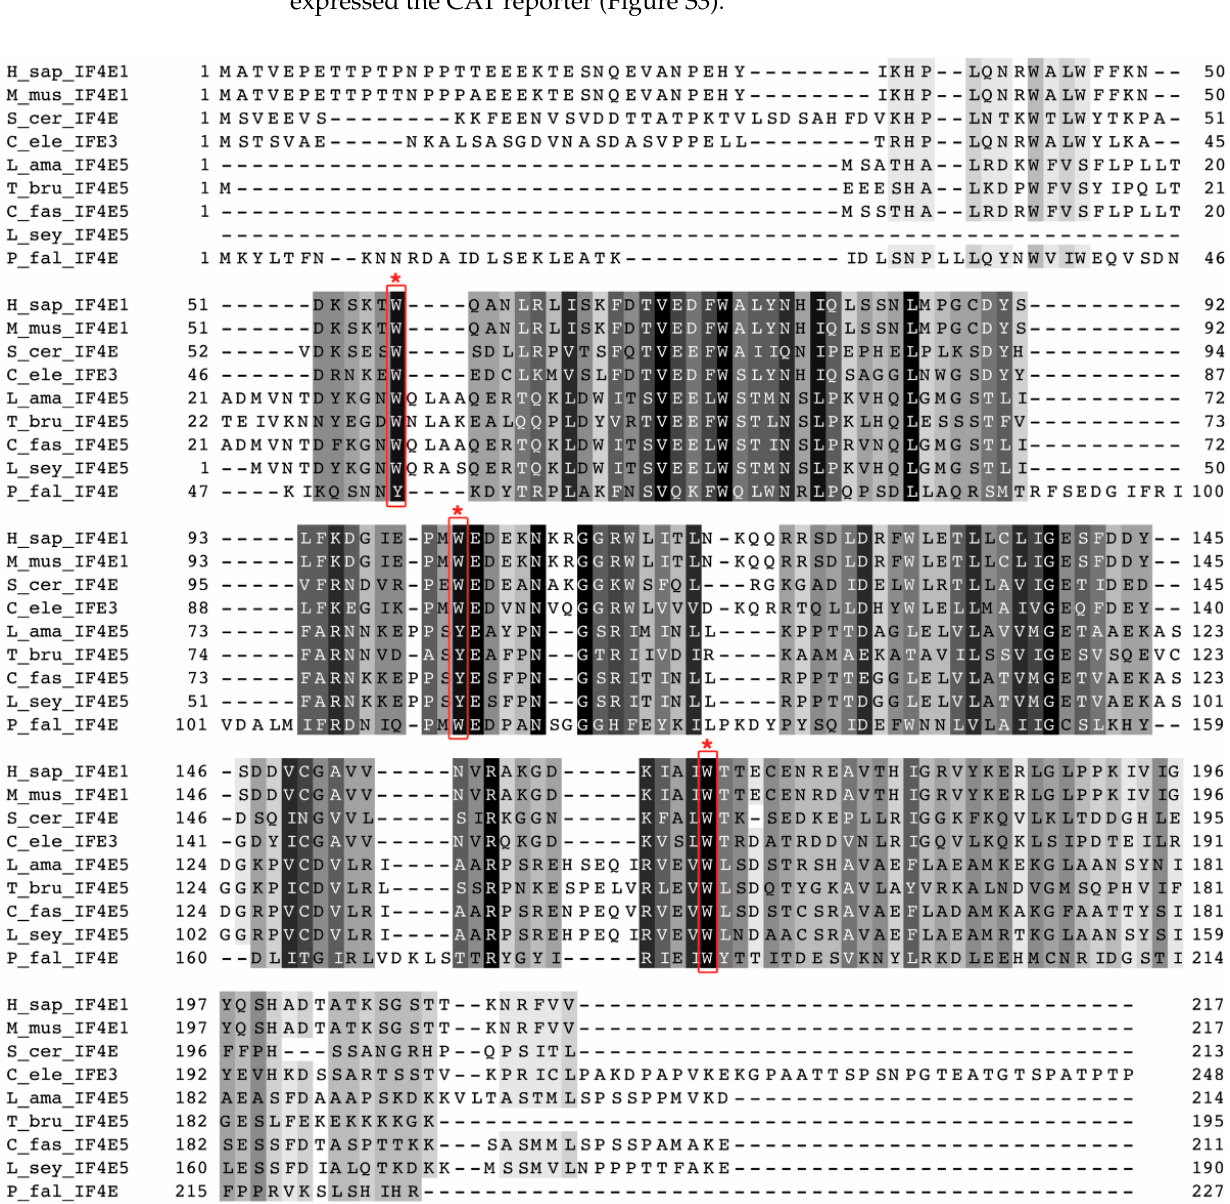
Figure 1. Alignment of LeishIF4E-5 from L. amazonensis with its protozoan orthologs, with eIF4E-1 from mammals, with yeast eIF4E and C. elegans IFE-3 . The alignment includes sequences of LeishIF4E-5 from Leishmania amazonensis (L_ama_IF4E5) , Trypanosoma brucei (T_bru_IF4E5), Crithidia fasciculata (C_fas_IF4E5) and Leptomonas seymouri (L_sey_IF4E5). It also includes the sequences of the canonical eIF4E from Homo sapiens (H_sap_IF4E-1), Mus musculus (M_mus_IF4E-1) and Saccharomyces cerevisiae (S_cer_IF4E5) along with IFE-3 from C. elegans (C_ele_IFE3) and P. falciparum (P_fal_IF4E). All sequences were subjected to multiple sequence alignment to highlight their homologies. Conserved tryptophan residues involved in cap-binding are marked with asterisks. The multiple sequence alignment was performed using MAFFT, version 7. Sequence conservations were generated by Jalview and are highlighted in